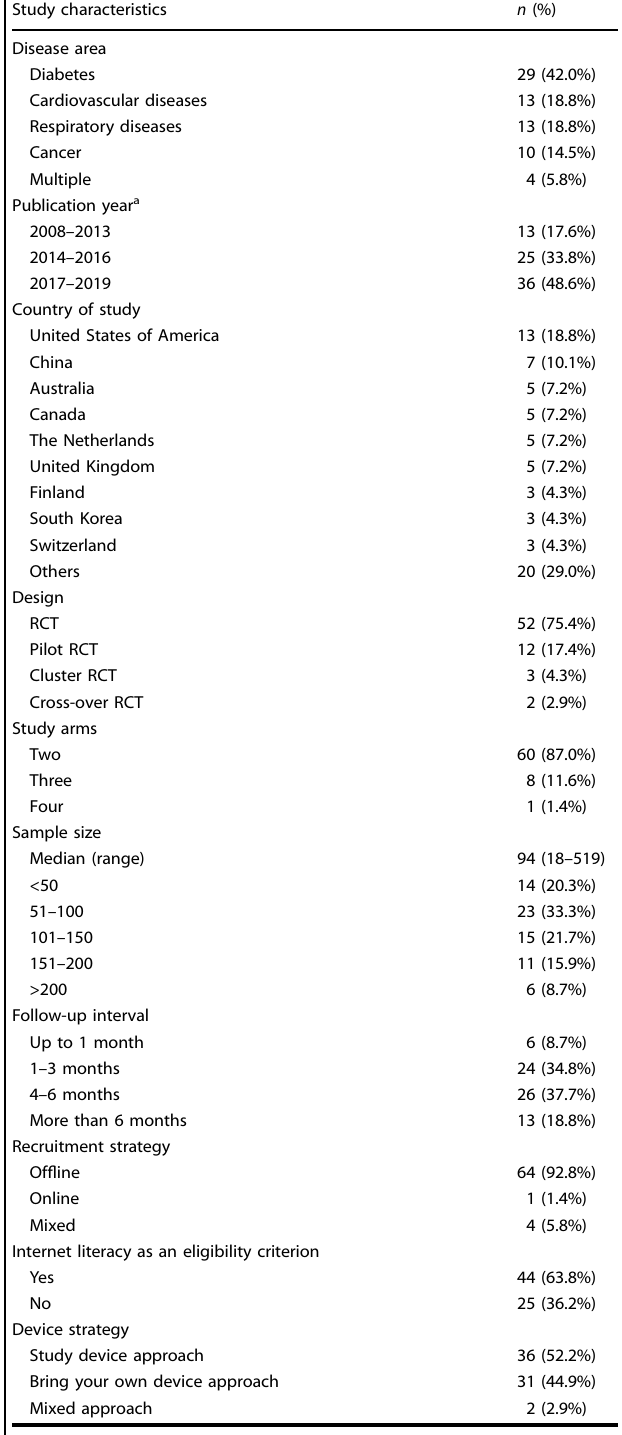
Table 1. Key characteristics of included studies ( n =